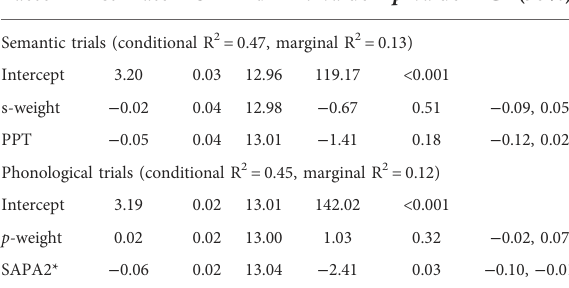
TABLE 8 Summary of aWPVT response latency linear mixed effect